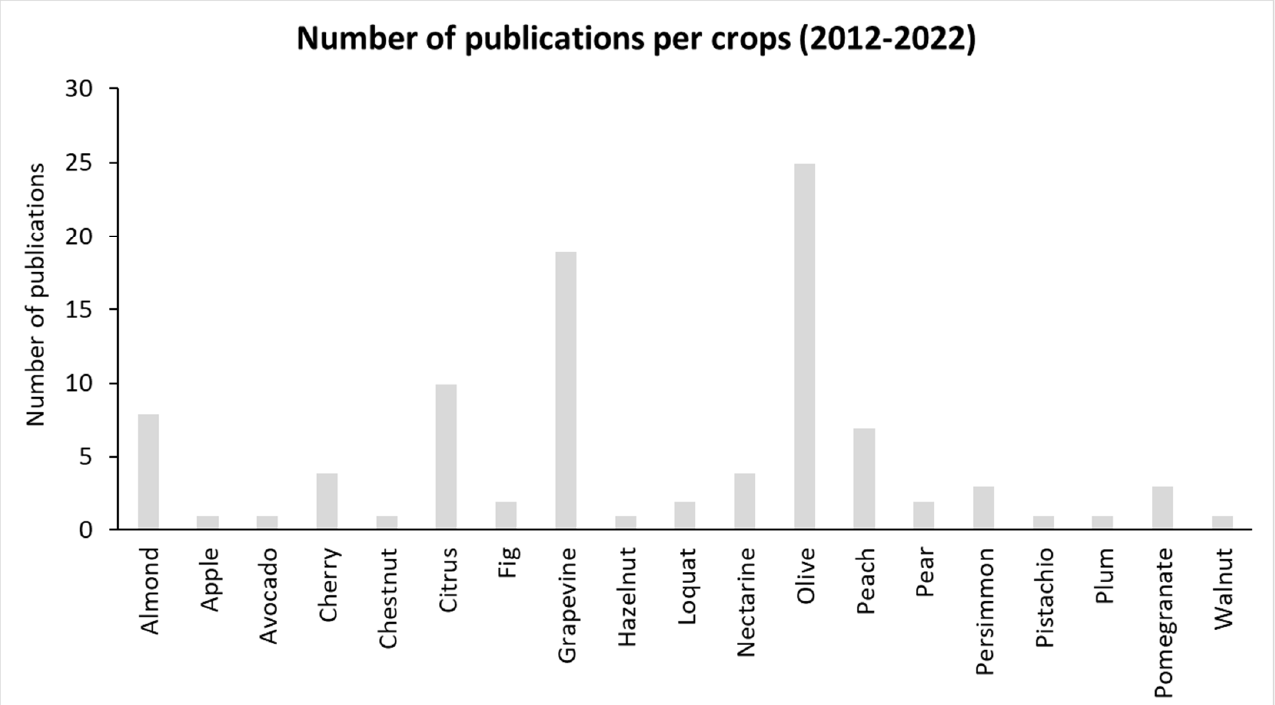
Figure 3. Number of publications studying the application of the different sensors and methodologies from 2012 till 2022 per Mediterranean fruit and nut tree crops from a total of 83 references.